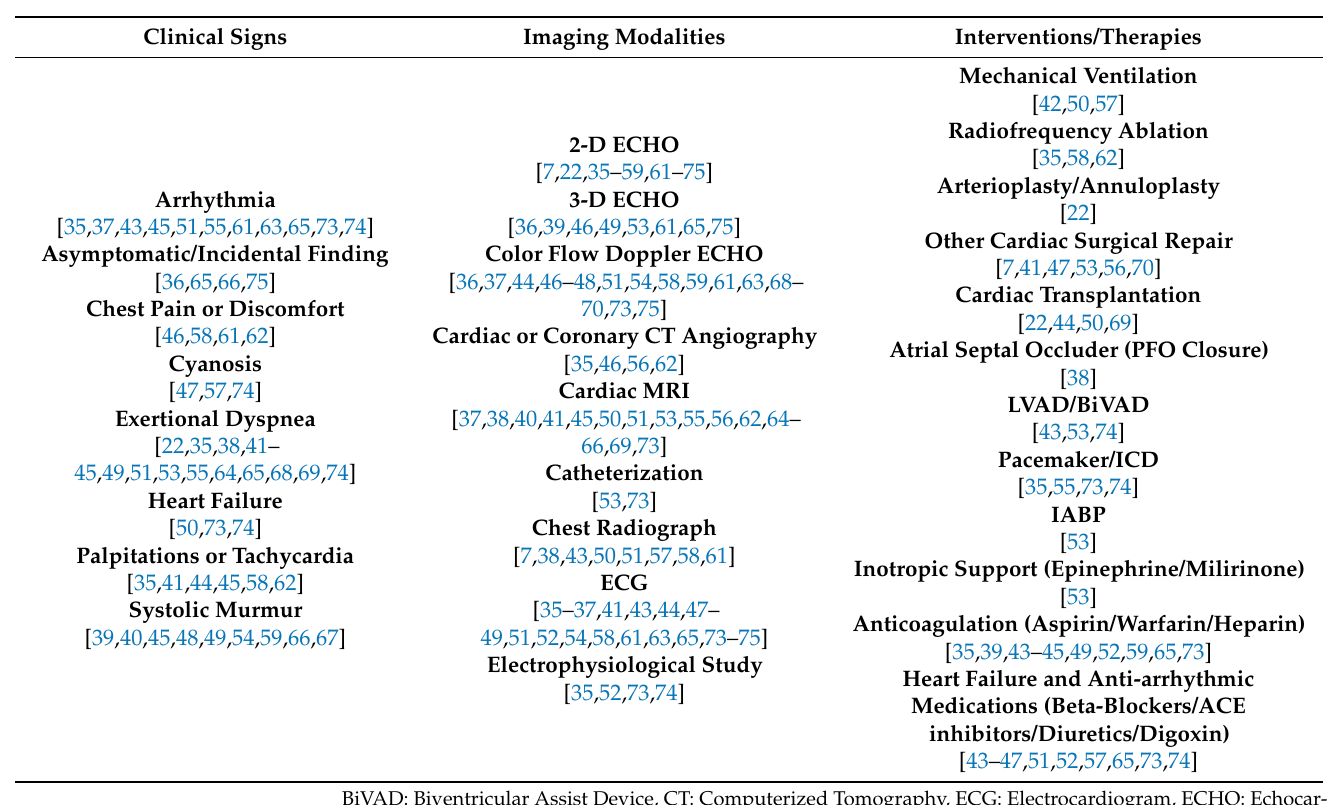
Table 2. Clinical signs, imaging modalities, and interventions noted among all EA/LVNC case reports.